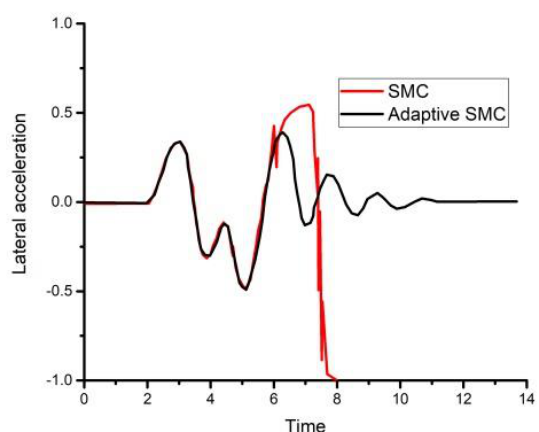
Figure 21. Lateral